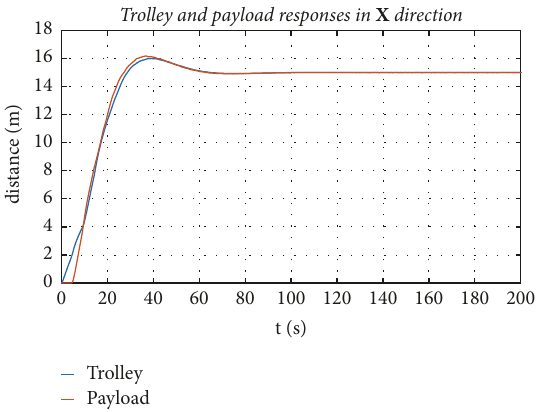
Figure 2: Trolley and payload responses in X direction without vibration control.